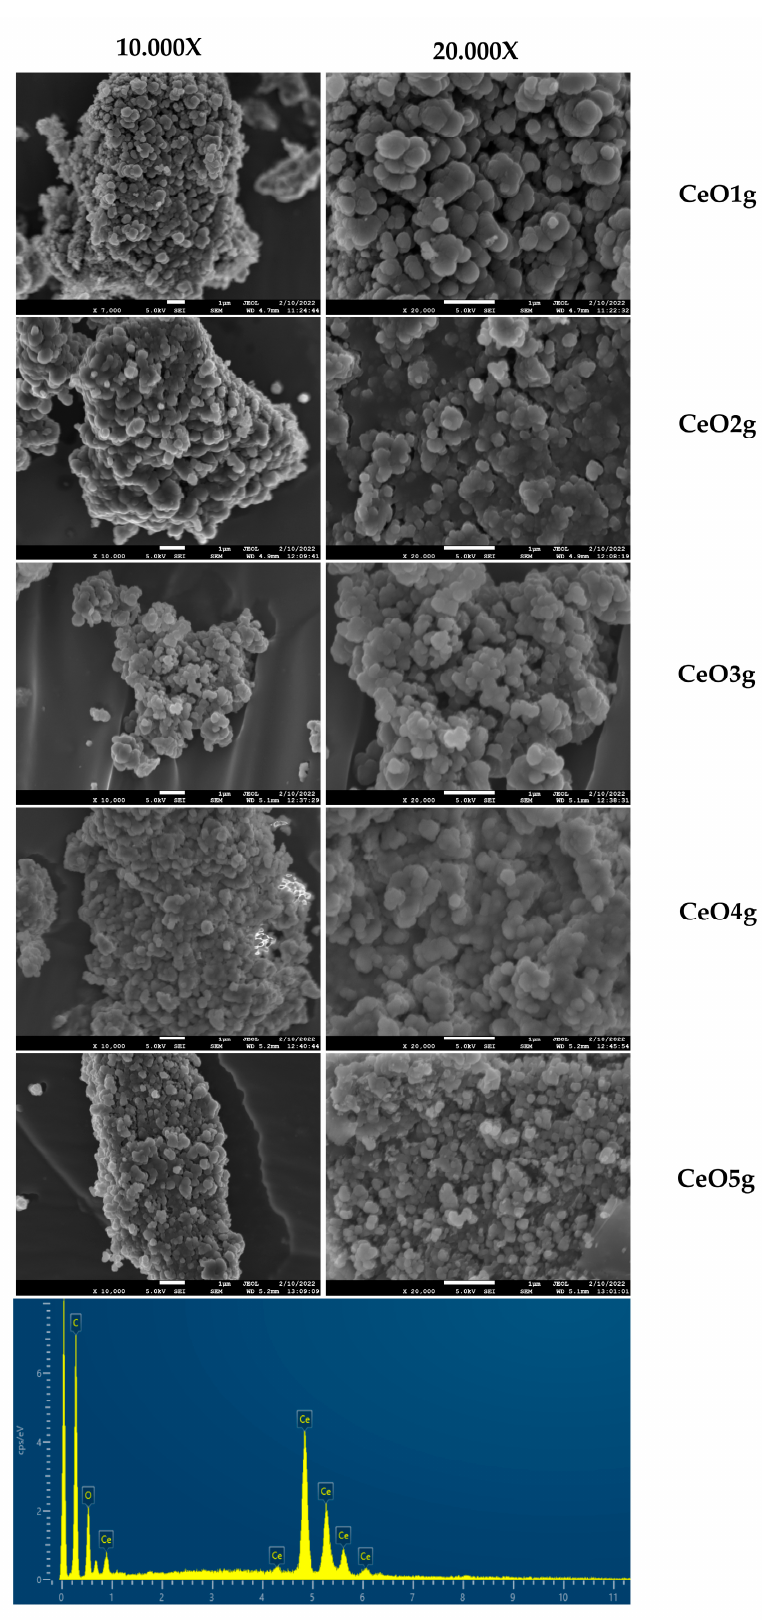
Figure 3. SEM micrographs of synthesized materials and representative EDS spectrum verifying the presence of cerium.